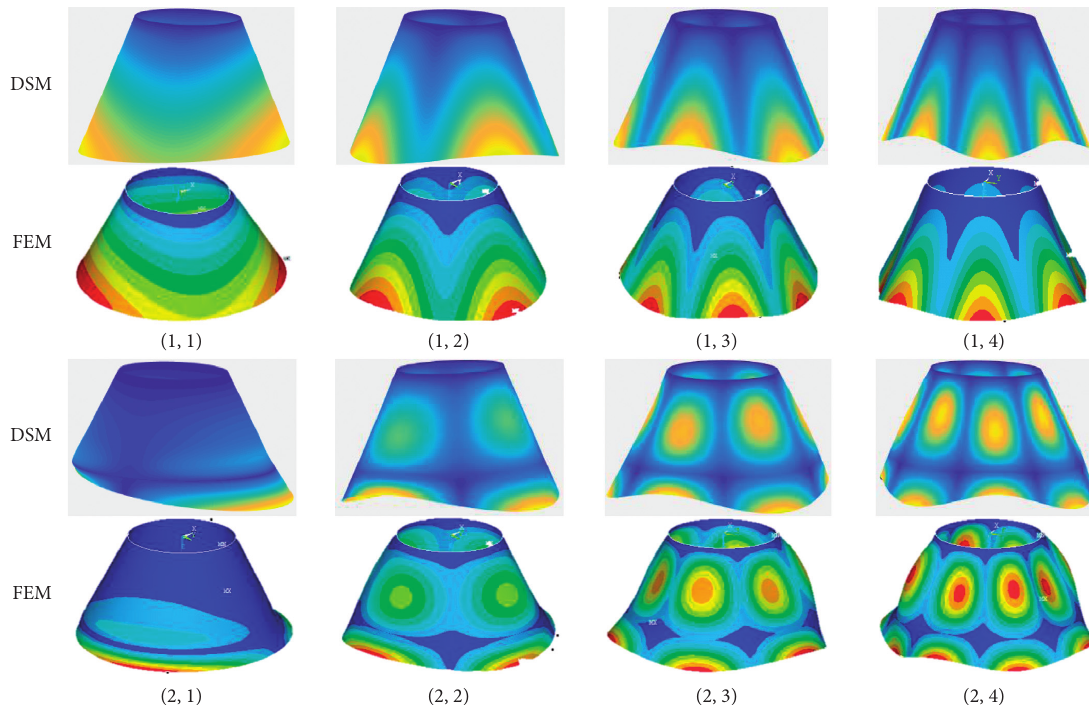
Figure 5: Mode shapes of conical shell under C–F boundary